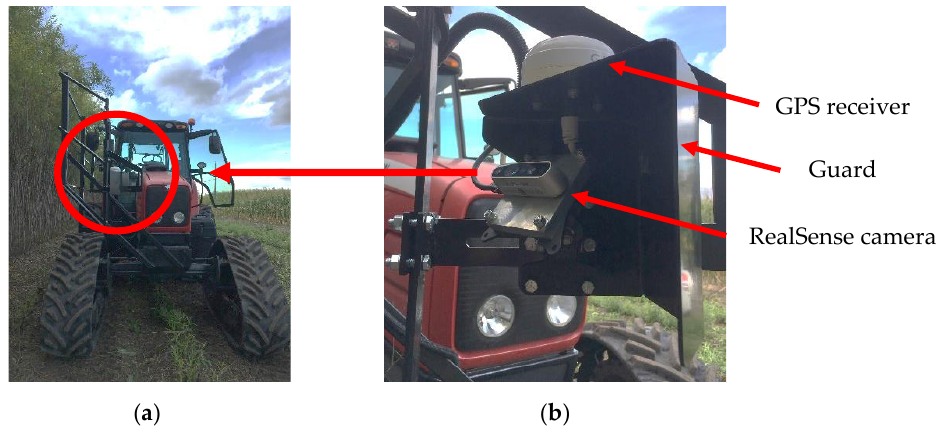
Figure 1. ( a ) Overall view of final camera position; ( b ) close view of final camera and Global Positioning System (GPS) mount.